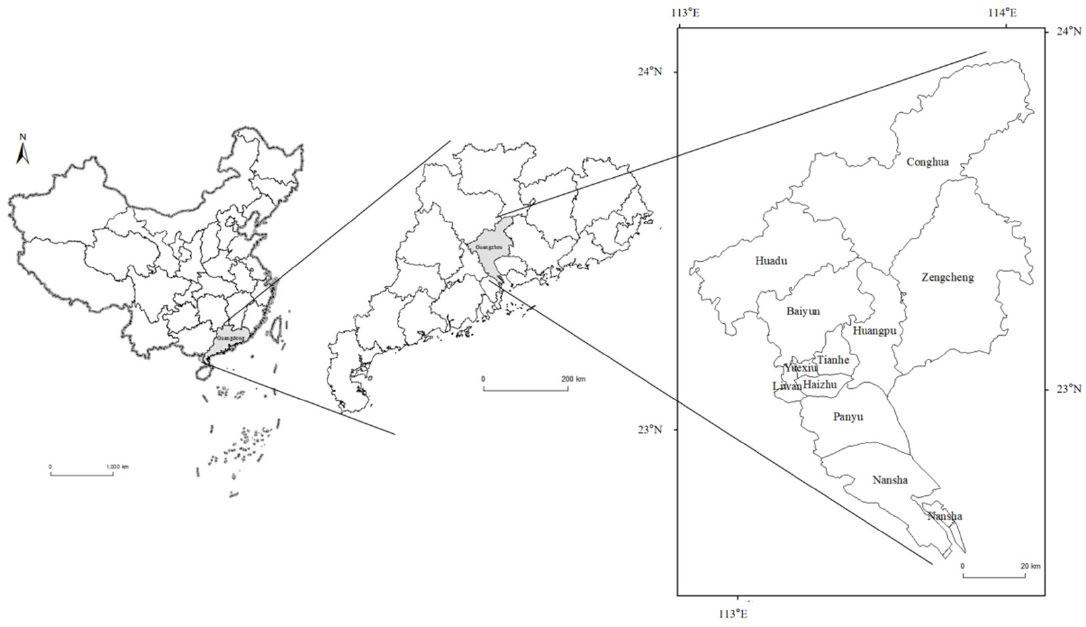
Figure 1. Location of Guangzhou, China.